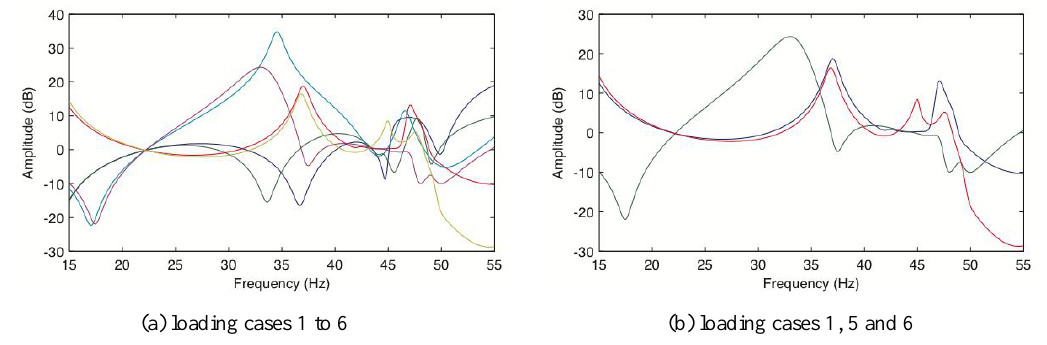
Fig. 7. Transmissibility functions between 2 points.